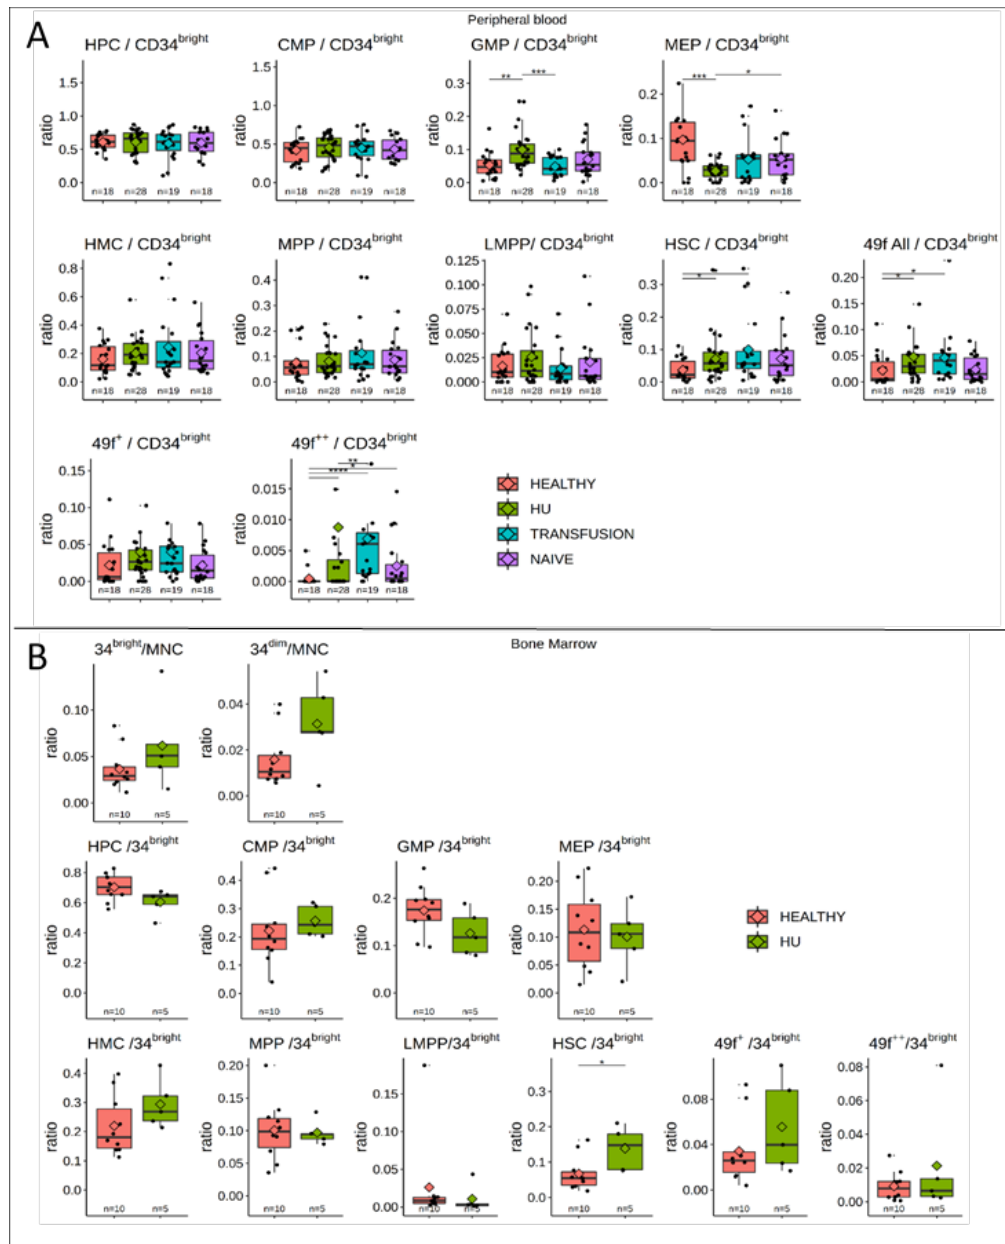
Figure 5. SCD patients are depleted in circulating MEPs but exhibit higher frequencies of HSCs and 49f cells: ( A ) Boxplots illustrating the proportion of HSPCs in PB relative to the number of CD34 bright cells. Boxplots and significance are as in Figure 1. The proportion of circulating MEPs/CD34 bright cells is lower in all SCD patients than in controls, but the decrease is more pronounced in HU patients. By contrast, the proportions of HSCs and 49f cells / CD34 bright cells is higher in HU and transfusion treated patients than in controls and naive individuals. Some, but not all, of the increase in HSC and 49f cells is caused by the increased proportion of 49f ++ cells. ( B ) BM analysis: BM from 10 controls and 5 SCD patients treated with HU were analyzed by FACS using the same protocol as the PB cells. The number of CD34 bright /MNCs is higher in SCD patients, but the difference does not reach significance. None of the concentration of HSPCs relative to the CD34 bright cells, except for HSCs, is significantly different between the SCD patients and the controls. * p ≤ 0.05; ** p ≤ 0.01; *** p ≤ 0.001, **** p ≤ 0.0001.